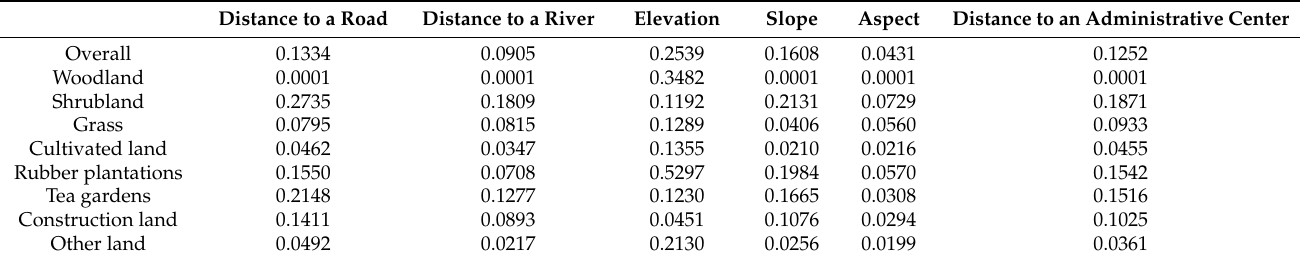
Table 4. Cramer’s V coefficients indicating correlations between the influencing factors of land use change and land distribution. Distance to a Road Distance to a River Elevation Slope Aspect Distance to an Administrative Center Overall 0.1334